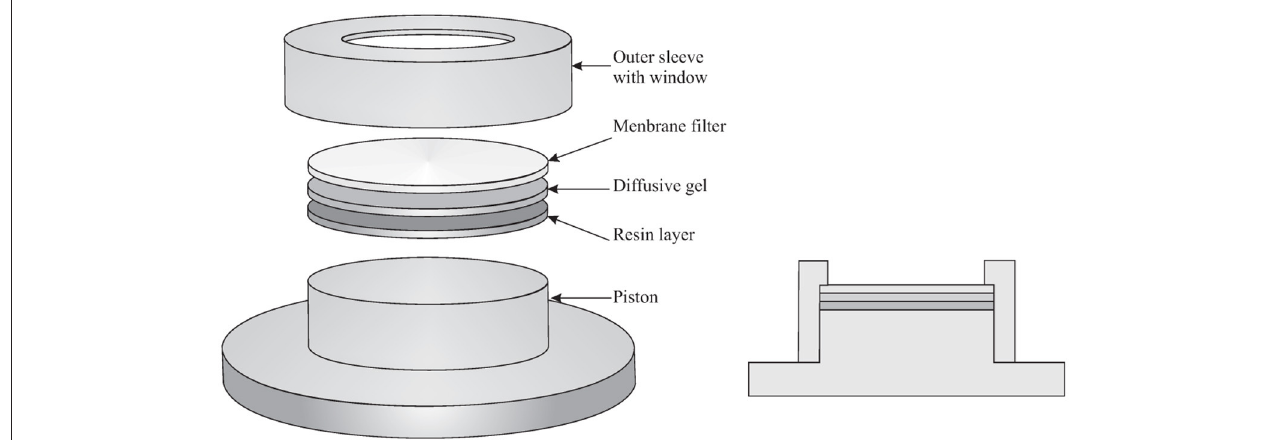
FIGURE 1 | Schematic drawing of the DGT device (Adapted from Averós et al.,